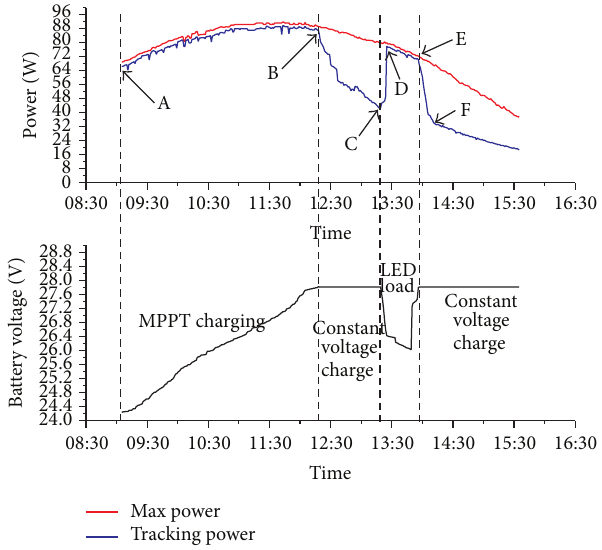
Figure 13: Change of MPPT controller’s tracking power and battery voltage in a sunny